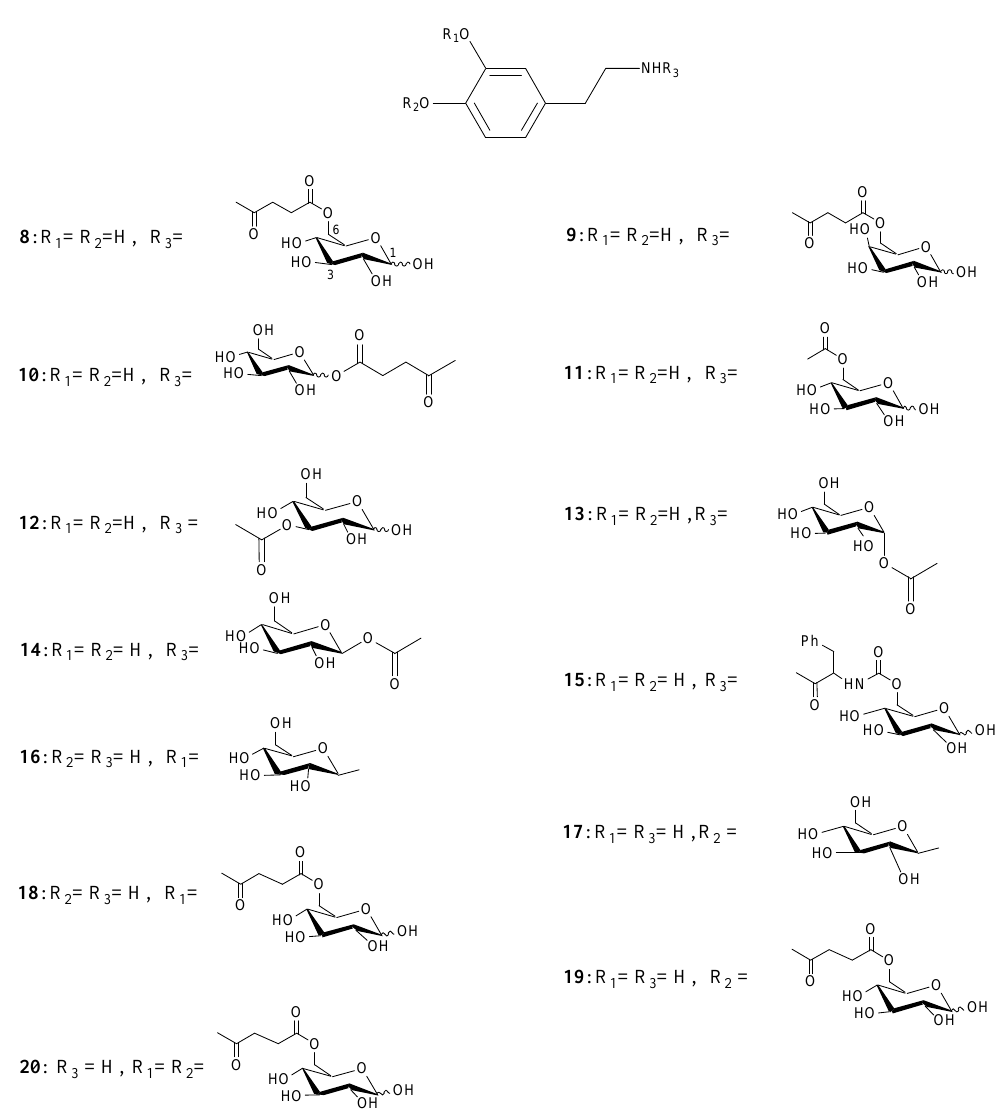
Figure 2 . Glycosyl DA